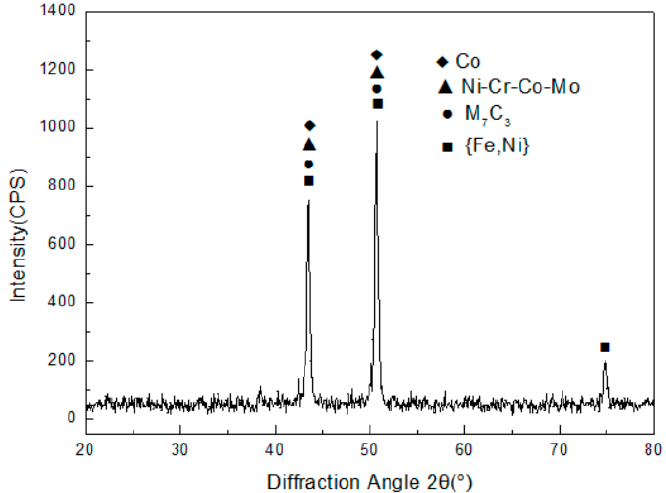
Figure 2. X-ray di ff raction result of Co-based cladding Figure 2. X-ray diffraction result of Co-based cladding coating.